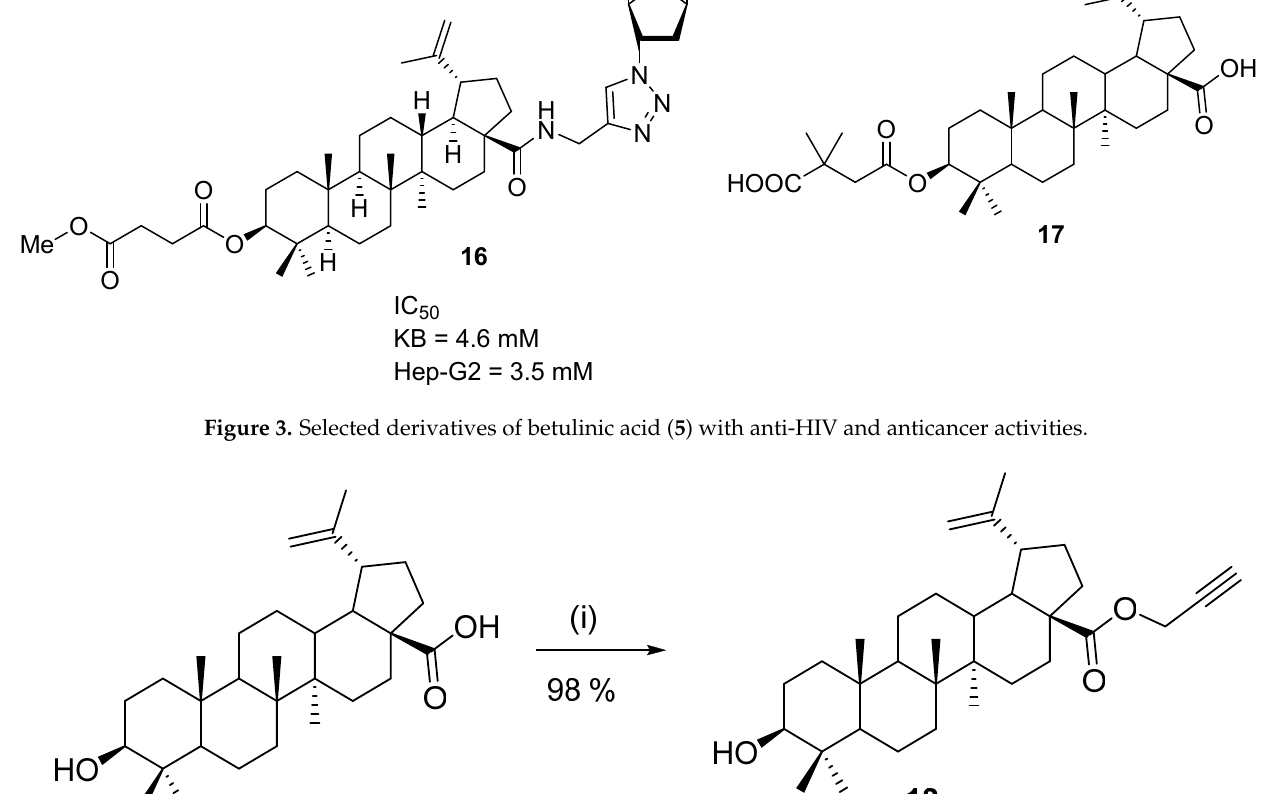
triazole derivatives by 1,3-cycloaddition reactions.